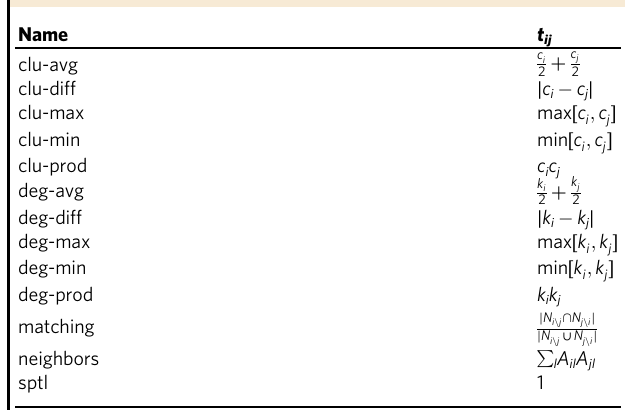
Table 2 A list of topological terms, t ij , used in the generative models [Eq.